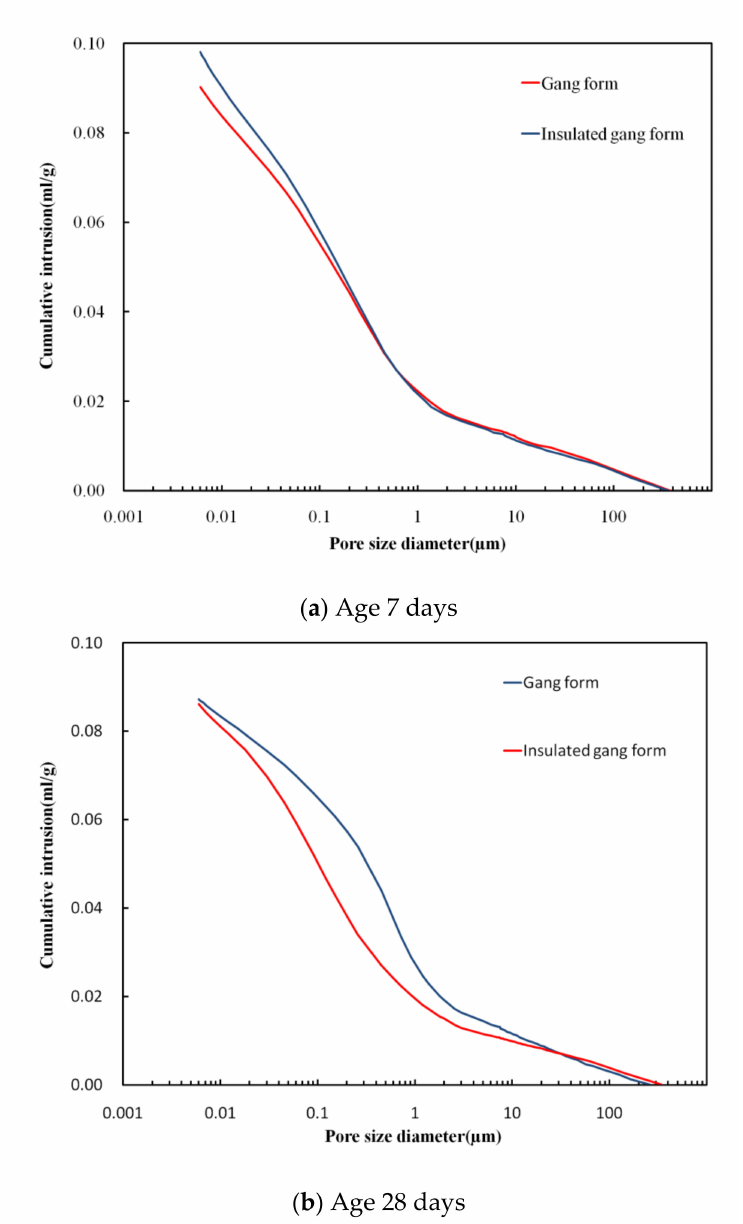
Figure 14. Cumulative pore